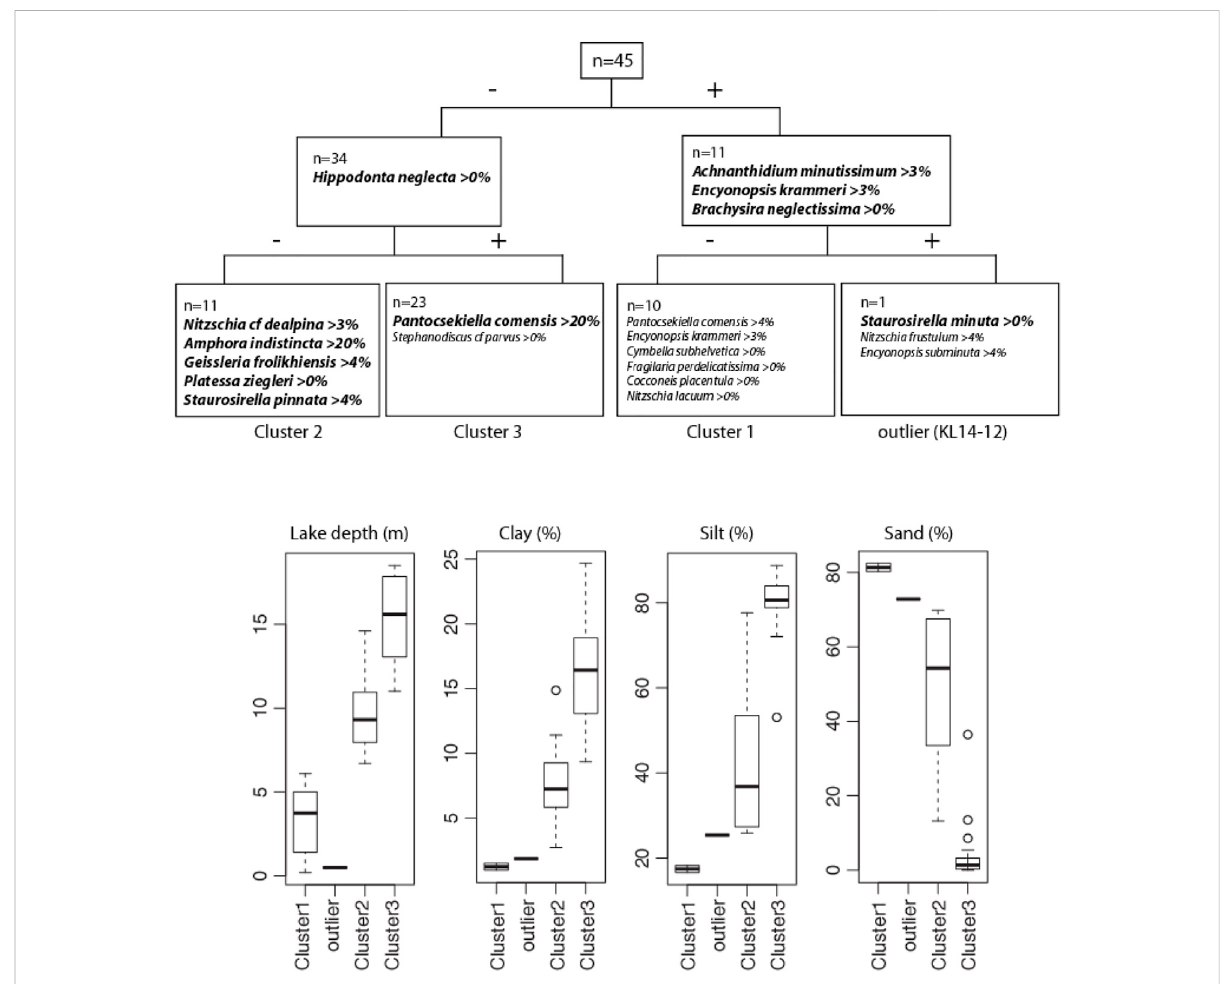
FIGURE 3 TWINSPAN classi fi cation dendrogram of the surface sediment diatom assemblages from Lake Kalakuli. Indicator species and their cut level are writteninbold,whilepreferentialspeciesarewrittenwithnormalfont.Belowthedendrogramareshowntheboxplotsforwaterdepthandgrainsize components for each diatom clusters de fi ned by TWINSPAN. The 25th and 75th percent quartiles (excluding outliers) are drawn using a box, the medianisshownwithahorizontallineinsidethebox.Thewhiskersrepresenttheupperandlower ‘ innerfences ’ thataredrawnfromtheedgeof theboxuptothelargest/lowestdatapointlessthan1.5timestheboxheight.Outliers,i.e.,valuesoutsidetheinnerfences,areshownascirclesifthey lie further from the edge of the box than three times the box